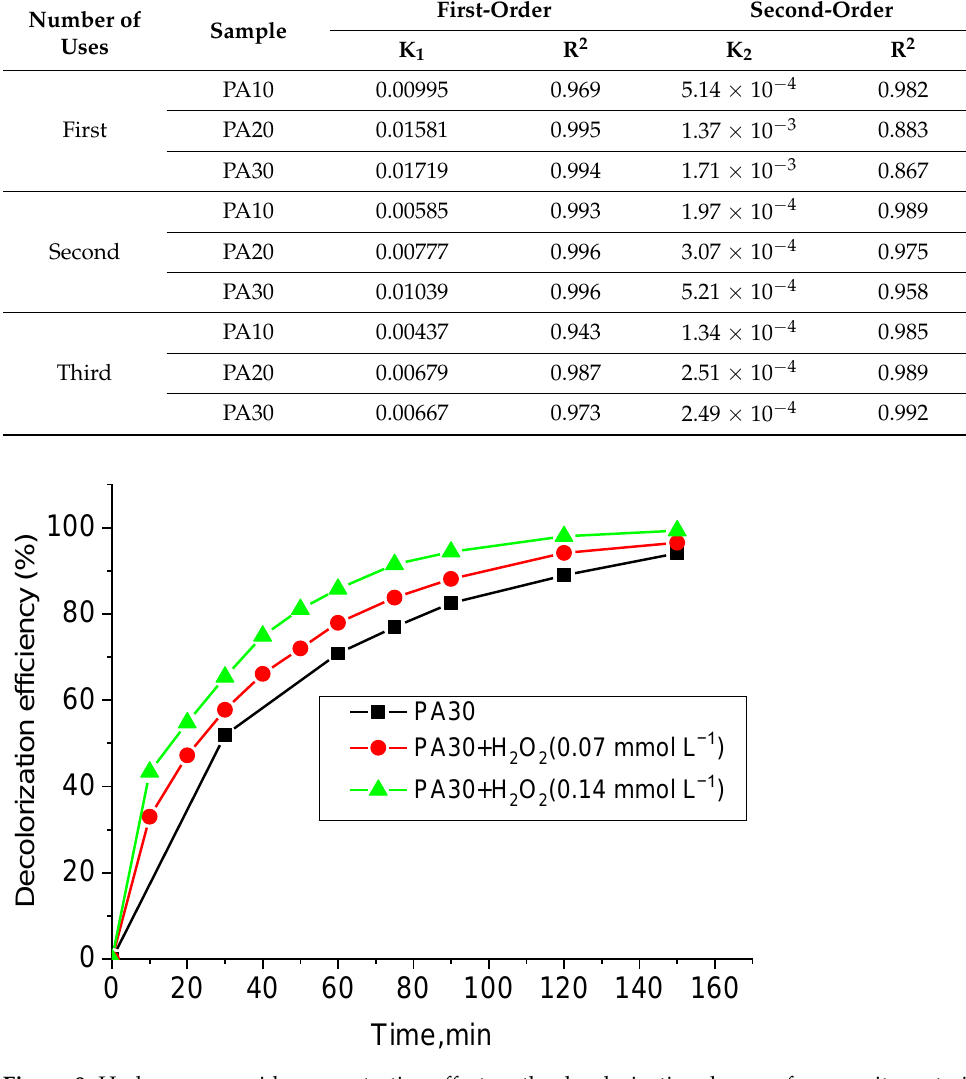
Figure 9. Hydrogen peroxide concentration effect on the decolorization degree of composite material PA30. Table 6. Kinetic parameters of the discoloration reaction run with adsorbent PA30 and the addition of H 2 O 2